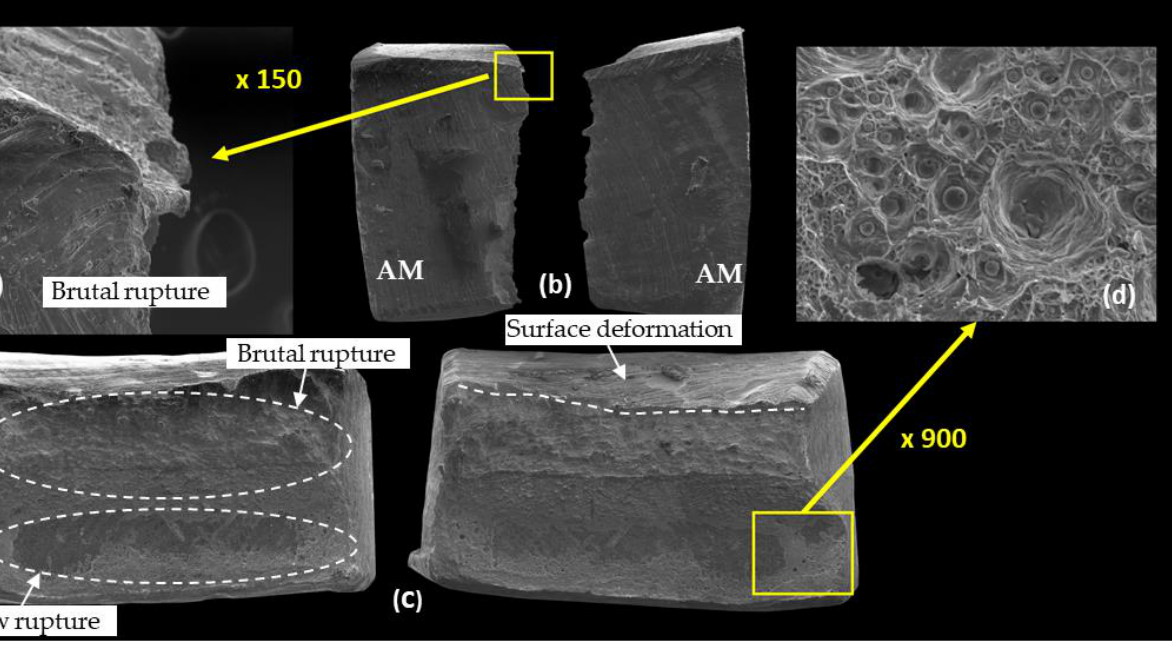
Figure 17. SEM images exhibiting the fracture surfaces of fatigue-tested AM-AM specimen: ( a ) macrography of the crack initiation, ( b ) fracture micrography on the welding surface, ( c ) failure surface macrography, ( d ) porosity in the failure surface.